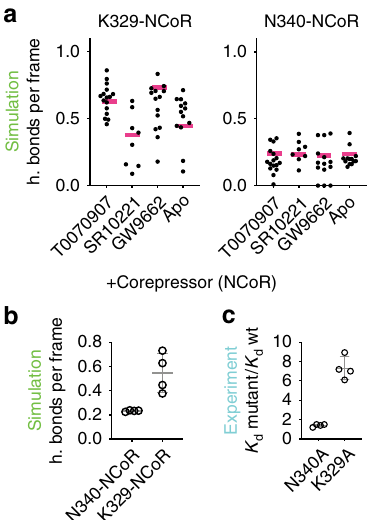
Fig. 4 Simulation prevalence of NCoR to PPAR γ binding correlates with experiment. a The prevalence of the indicated hydrogen and salt bridge bonds in individual 1 μ s conventional MD runs of representative structures from low energy wells (black circles) and the overall Boltzmann weighted average (pink) for the indicated complexes. b Boltzmann average prevalence of hydrogen bonding between the helix 3 charge clamp residue (K329) and NCoR and between a helix 4 residue (N340) and NCoR is shown. The average and standard deviation of these 4 values are shown (0.23±0.005 and 0.55±0.16). p = 9E − 3; 95% CI for difference magnitude is 0.1 – 0.5; t = 3.8; d f = 6; unpaired two-tailed t test. c The average decrease in af fi nity is greater for a mutation abolishing the helix 3 charge clamp (K329A) than for one abolishing the helix 4-NCoR bonding (N340A). The average and standard deviation of these 4 values are (1.4±0.14 and 7.3 ±1.18). p = 6E − 5; 95% CI for difference magnitude is 4.4 – 7.4; t = 9.92; d f = 6; unpaired two- tailed t test. These data are also presented in Supplementary Fig. 11. Each open circle represents the average K d of the indicated mutant from two independent experiments divided by the average K d of wt from four independent experiments for apo and PPAR γ LBD bound to T0070907, SR10221, or GW9662. Source data are provided as a Source Data fi le (Source